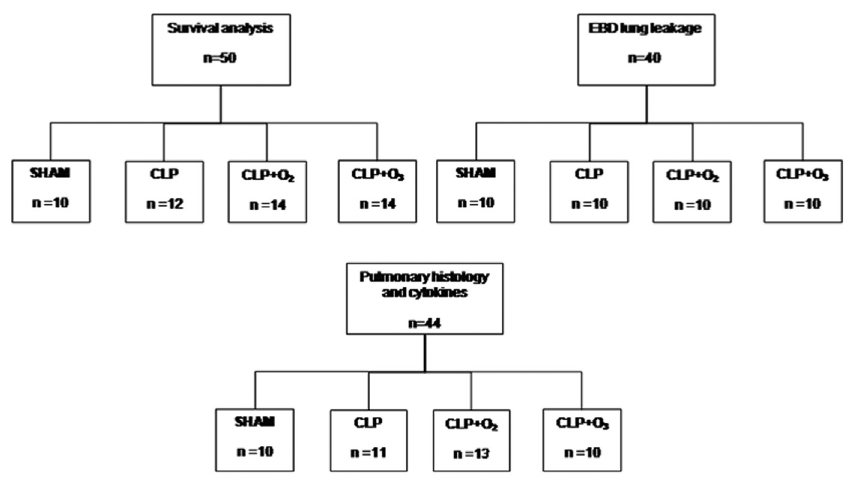
Figure 1 - Study design. The animals were assigned to 4 groups: 1) SHAM, animals submitted to laparotomy and exposure of the cecum; 2) CLP, animals underwent cecal ligation/puncture and were observed; 3) CLP+O CLP+O , animals submitted to cecal ligation/puncture and were treated i.p. with O 3 CLP+O =14). Pulmonary vascular permeability was evaluated by the EBD lung leakage method in 40 animals (all groups with n=10). Cytokine sampling 3 and histological analysis were studied in 44 animals (SHAM=10, CLP=11, CLP+O